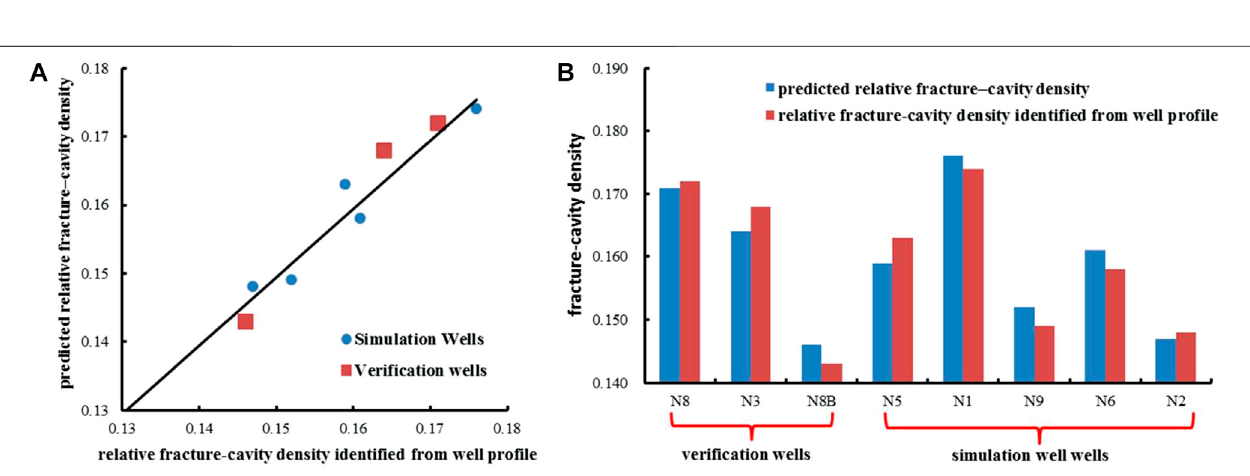
FIGURE17|(A) Relationshipsbetweentherelativefracture-cavitydensityidenti fi edfromwellpro fi leandthepredictedrelativefracture – cavitydensity. (B) Theerror comparison of the relative fracture-cavity density identi fi ed from well pro fi le and the predicted relative fracture-cavity density.